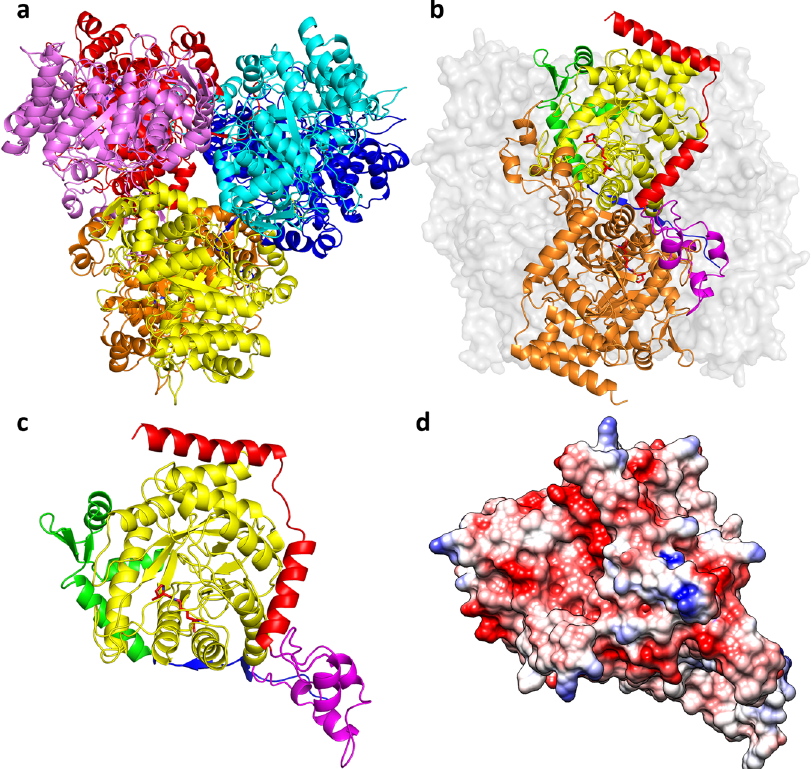
Fig. 1 Structure of MttB. Ribbon diagram of MttB hexamer viewed along ( a ) the threefold axis with dimer pairs in more similar colors (yellow, orange; cyan, blue; violet, red); and ( b ) the twofold axis with one subunit colored orange, and the other subunit colored by region: residues 2 – 22 in blue, 23 – 81 in green, TIM-barrel 82 – 395 in yellow, dimerization loop 396 – 452 in magenta, and 453 – 495 in red. Pyl334 is shown as red stick. c Structure of single subunit in ribbons colored as in ( b ). d Surface electrostatic potentials of single subunit with positive in blue (10 kcal/mol· e ) and negative in red ( − 10 kcal/mol· e ) in the same orientation as in ( c ).